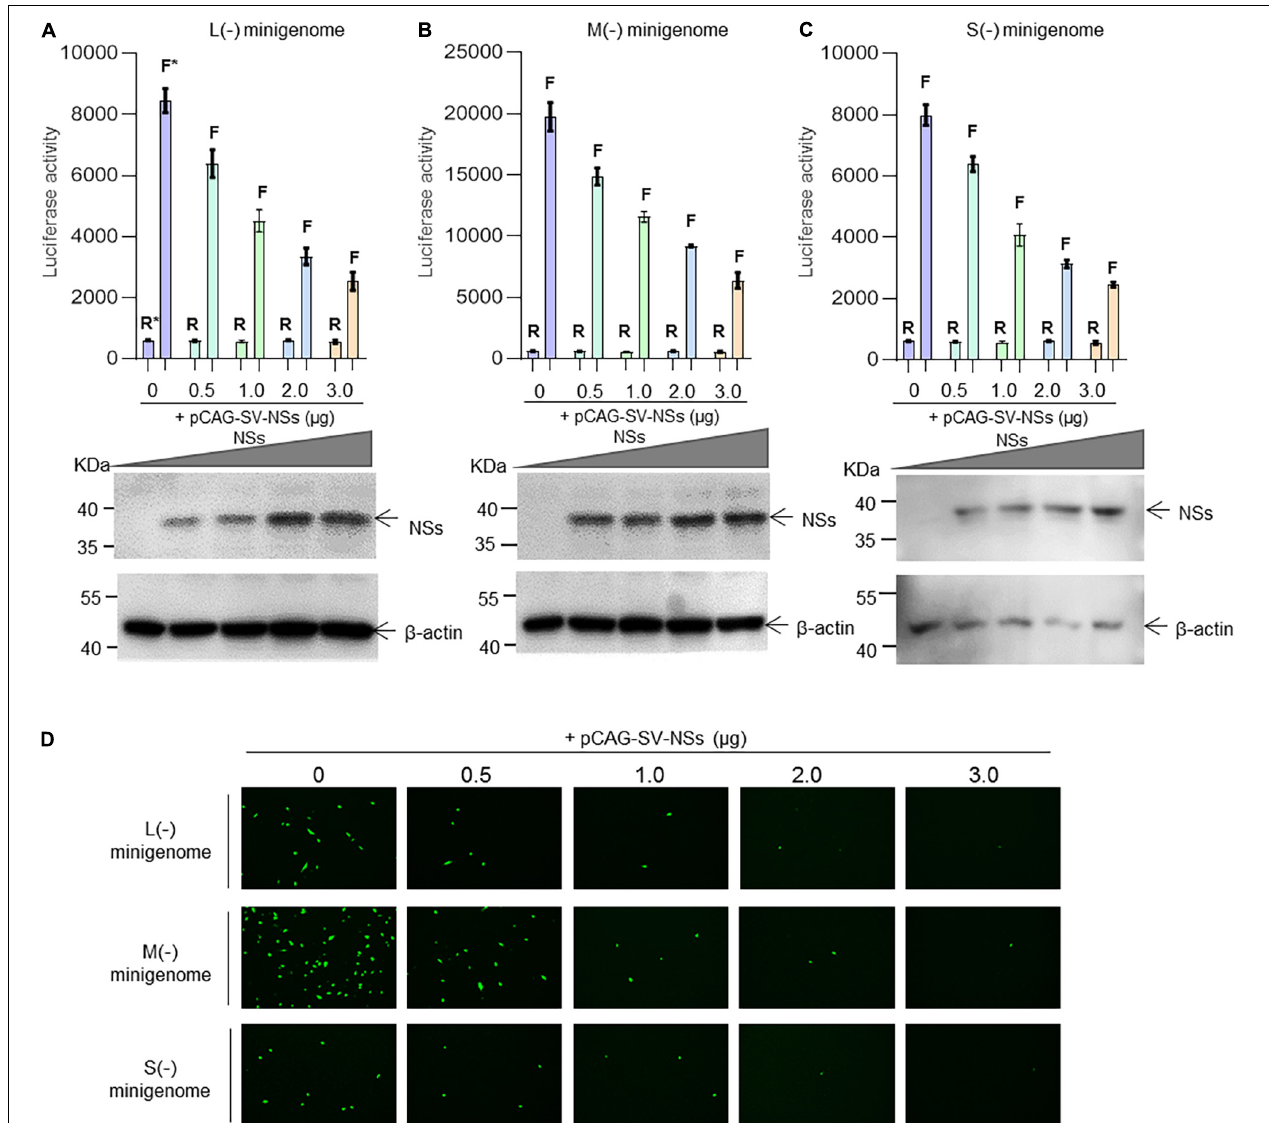
FIGURE 3 | SFTSV NSs downregulate virus-like RNA synthesis in a dose-dependent manner. We adopted a minigenome (–) reporter system combined with Western blotting to determine whether the regulatory effect is dose-dependent. BHK-21 cells cultured in 12-well plates were transfected with 1.0 µ g of minigenome (–) plasmids (pRF42-L/M/SUTR-FLuc or pRF42-L/M/SUTR-EGFP) or control plasmid pRF42-FLuc, 0.5 µ g of RdRp, N, and NSs expression plasmids, along with 10 ng of internal control plasmid pRL-TK (omitted for EGFP reporter system) to express Renilla luciferase. The activity of firefly luciferase and Renilla luciferase was measured, and data for L (–) ( A , top), M (–) ( B , top), and S (–) ( C , top) are presented as the mean ± SEM, n = 3. Meanwhile, the cell lysates of L (–) ( A , bottom), M (–) ( B , bottom), and S (–) ( C , bottom) were subjected to Western blotting analysis with β -actin as an internal loading control. In the EGFP reporter system, cells were observed under fluorescence microscopy (D) . In (A–C) , the symbols “R” and “F” (marked with * in A ) above the indicated bars represent Renilla luciferase activation and firefly luciferase activation, respectively.